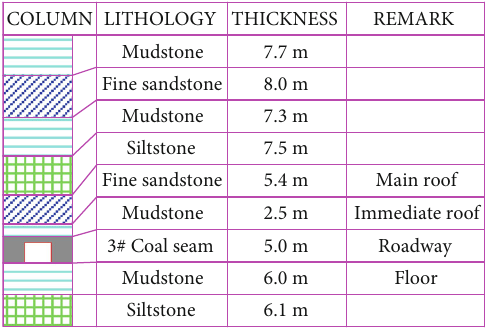
Figure 2: Comprehensive geological column of the 5306